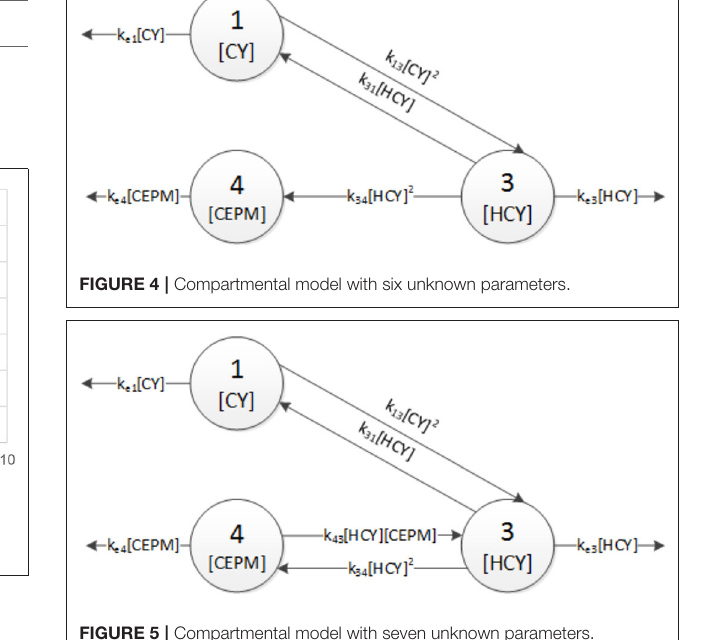
compartment for the elimination processes. The rates that are